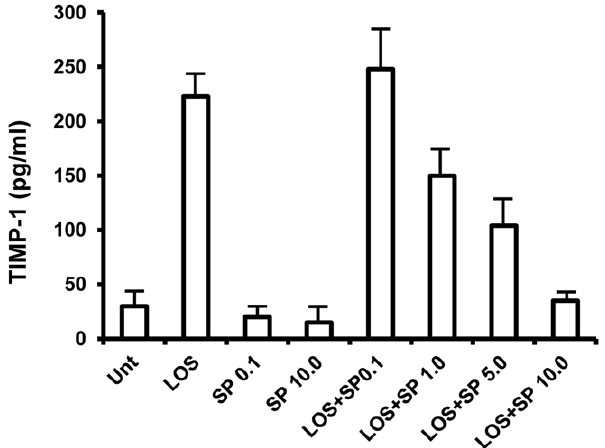
Figure 4. SP600125 selectively inhibits LOS-induced secretion of tissue inhibitor of matrix metalloproteinase-1 (TIMP-1) in macrophages. RAW 264.7 cells were seeded in a 96 well tissue culture plate as above and pretreated with SP600125 at different concentration for 1 h followed by LOS (100 ng/ml) treatment for 18 hrs. Supernatants were collected and levels of TIMP-1 were determined by ELISA. Results are representative of at least two independent experiments.